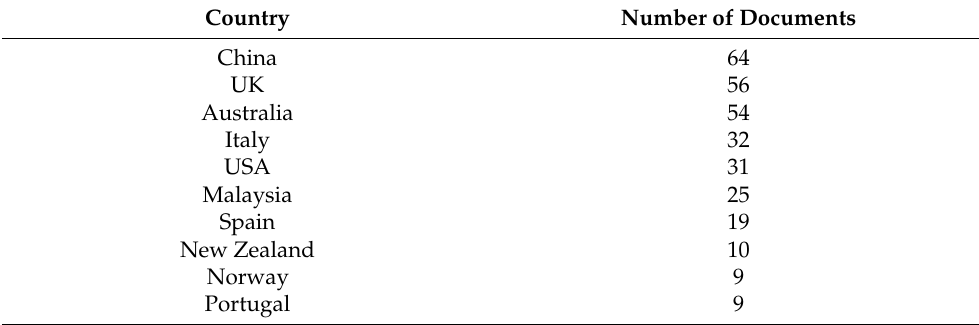
Table 10. Scientific production per country, performed with Biblioshiny version